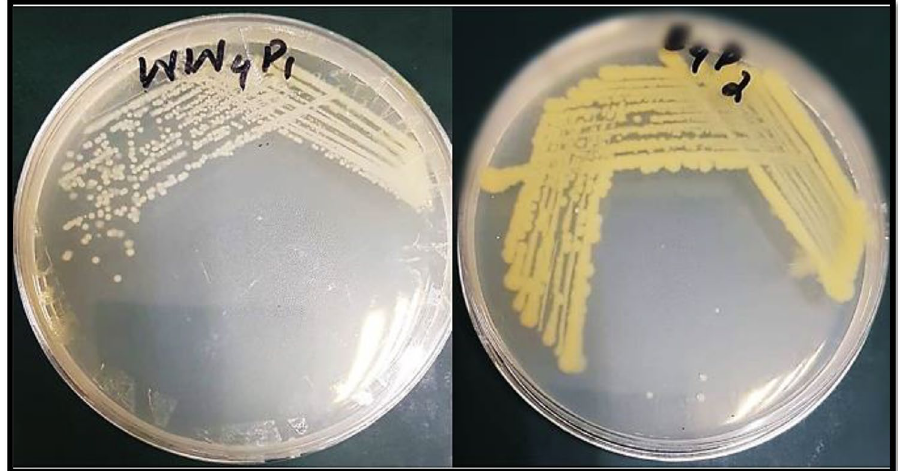
Fig. 1 Growth of bacterial isolates on MSM Agar